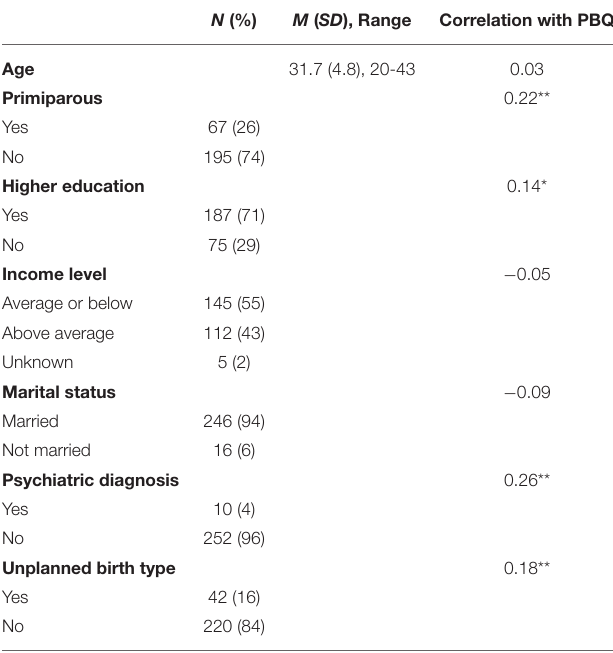
TABLE 1 | Sample demographic characteristics and correlations with PBQ score. TABLE 2 | Factor loadings for principal components analysis of PBI with Varimax